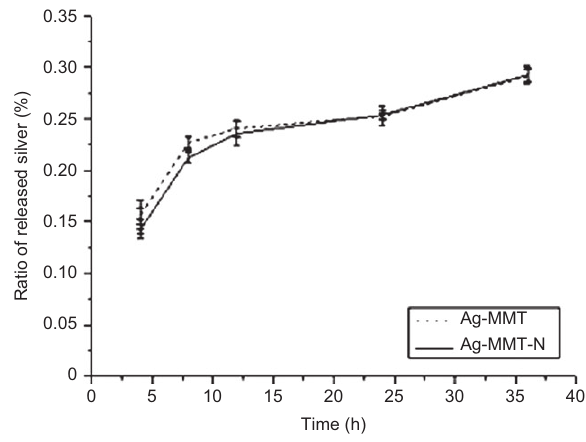
Figure 5 Comparison of the silver content of Ag-MMT-N and Ag-MMT. Figure 6 Comparison of the silver release properties of Ag-MMT-N